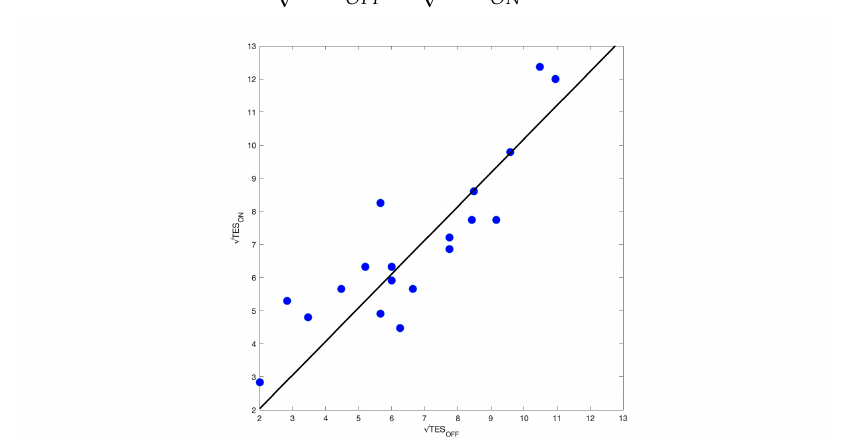
a a TES ON versus TES OFF . The black line is the best fit made using the least-squares Figure 12. method without